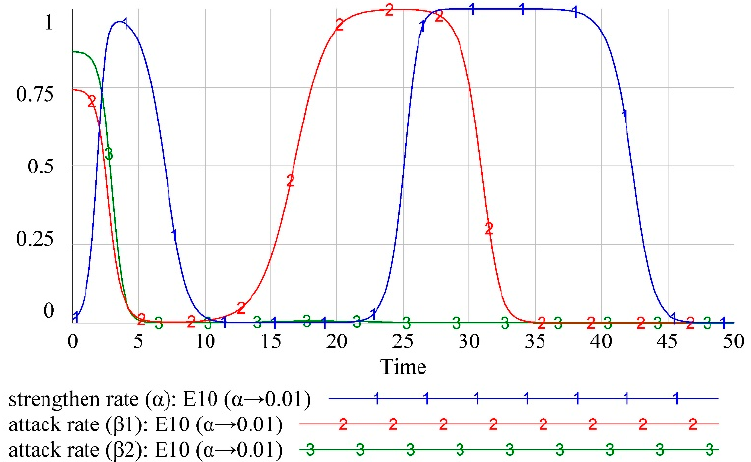
Figure 5. A mutation exists in the game results; E 10 ( α → 0.01 )